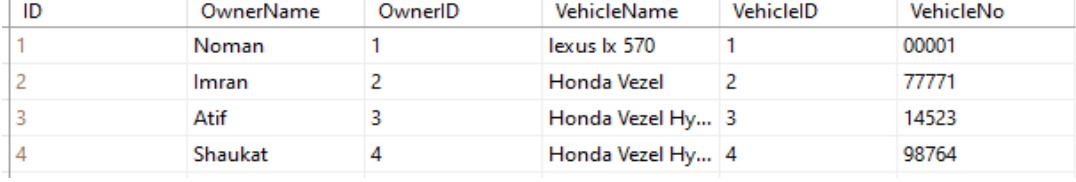
Figure 3. Vehicles database.